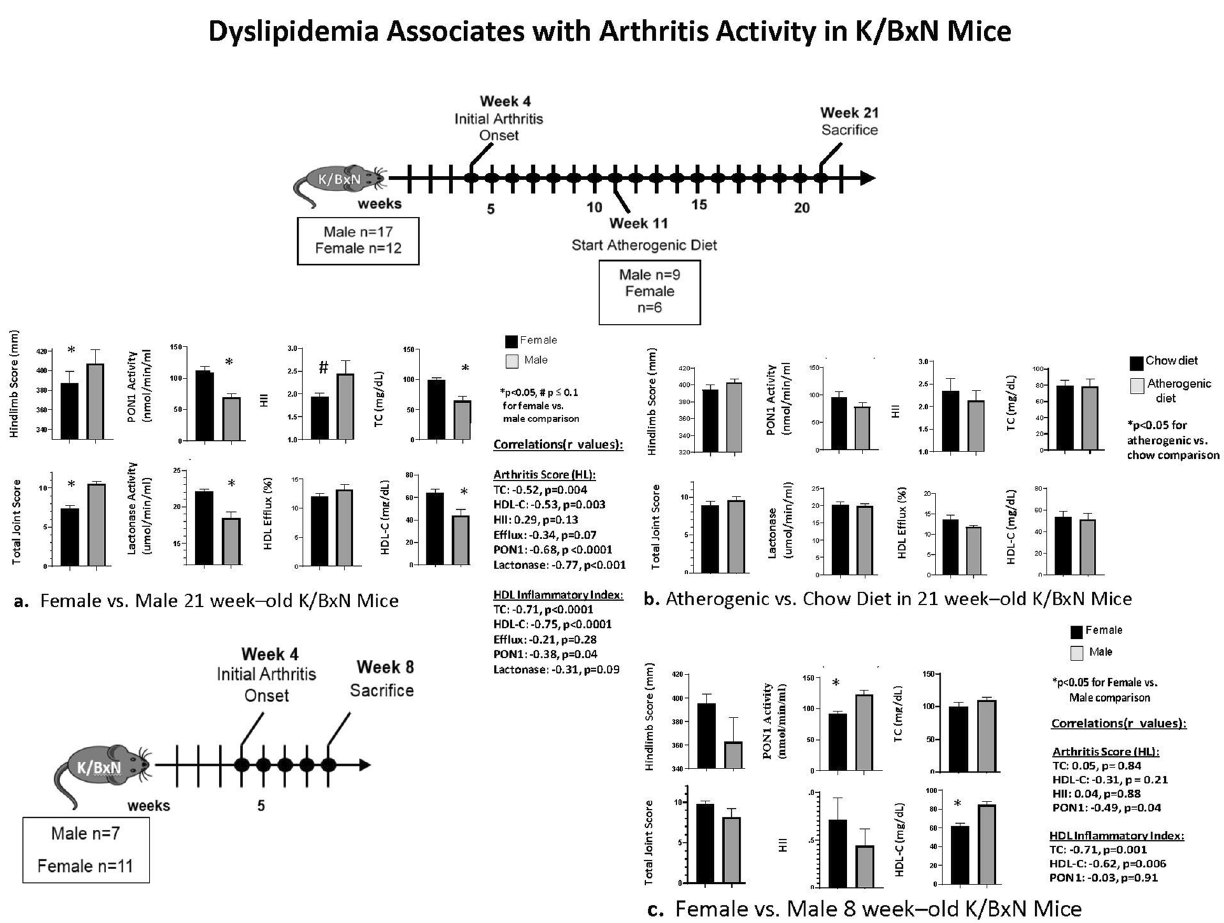
Figure 1. Associations of arthritis activity with dyslipidemia are shown in 21 week-old K/BxN mice (old, n = 29; 17 male, 12 female; ( A , B )) and 8 week-old K/BxN mice (young, n = 18; 7 male, 11 female; ( C )), which were generated by cross of NOD-Ag7 females and KRN males. In data shown in panels A and B, mice were maintained on chow until 11 weeks at which time 15/29 mice (6 female, 9 male) were switched to an atherogenic diet until sacrifice at 21 weeks. The remaining 14/29 mice were maintained on a chow diet until 21 weeks. ( A ) Comparisons of joint scores and lipid measures between more arthritic males with less arthritic females as well as correlations of arthritic scores with lipid measures. Correlations are also shown of HDL’s anti-oxidant capacity measured by the HDL inflammatory index (HII) with other lipid measures. ( B ) Comparisons of joint scores and lipid measures between mice on atherogenic versus chow diets. ( C ) Young mice were maintained on a standard mouse chow diet until sacrifice at 8 weeks. Comparisons of joint scores and lipid measures